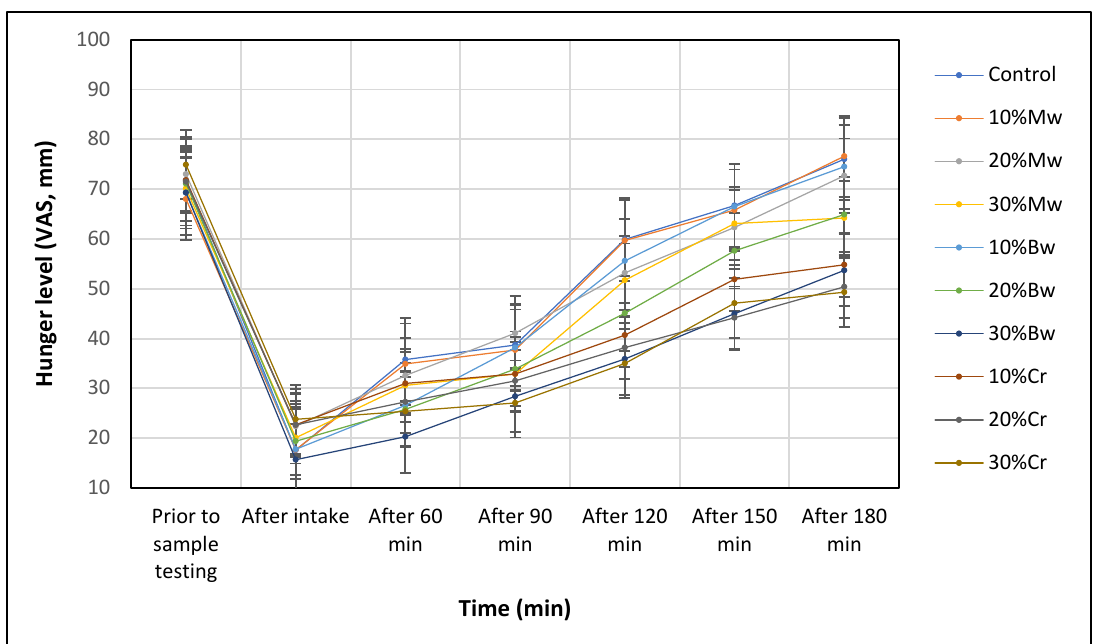
Figure 1. The determined hunger level after the ingestion of samples with the addition of edible insects for the entire study population.